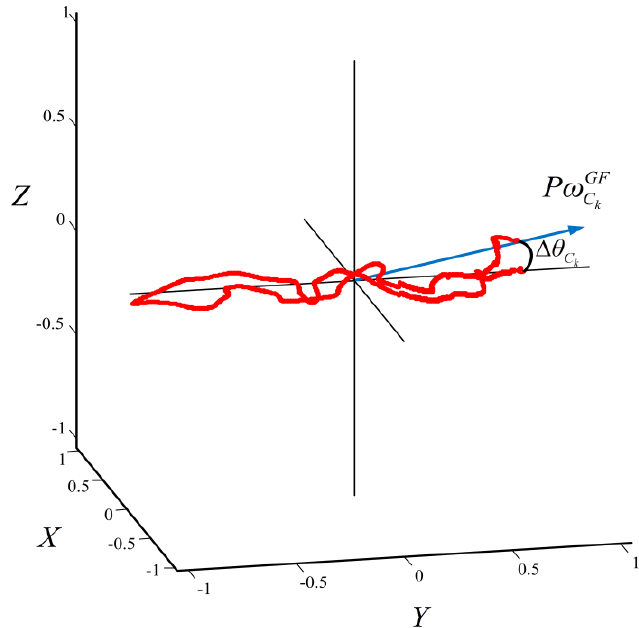
Figure 2. Angular velocity in GF and representation of biomechanical constraint for orientation correction. Principle component of angular velocity in the global frame ( ) and its deviation from forward axis of the movement ( ) are